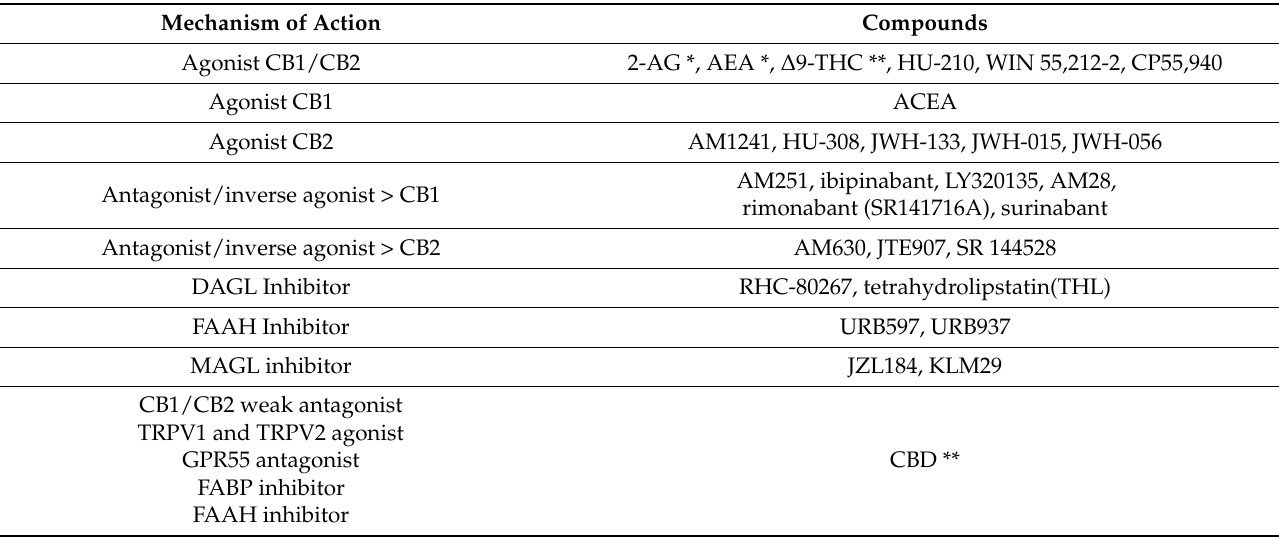
Table 2. Endogenous and synthetic modulators of the